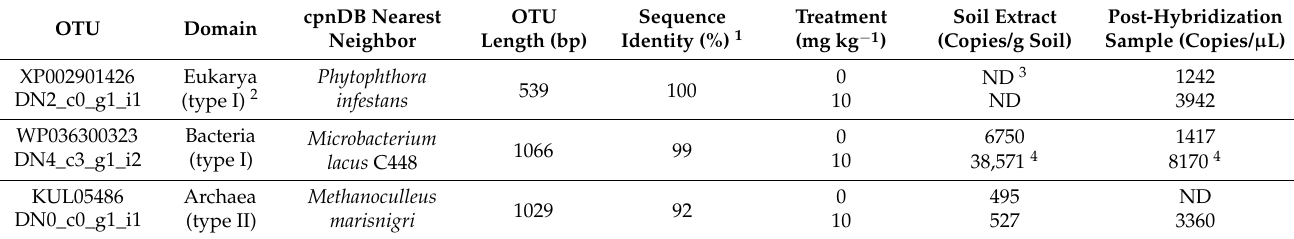
Table 4. Abundances of selected OTU from each domain in antibiotic treated soil samples, as determined by quantita- tive